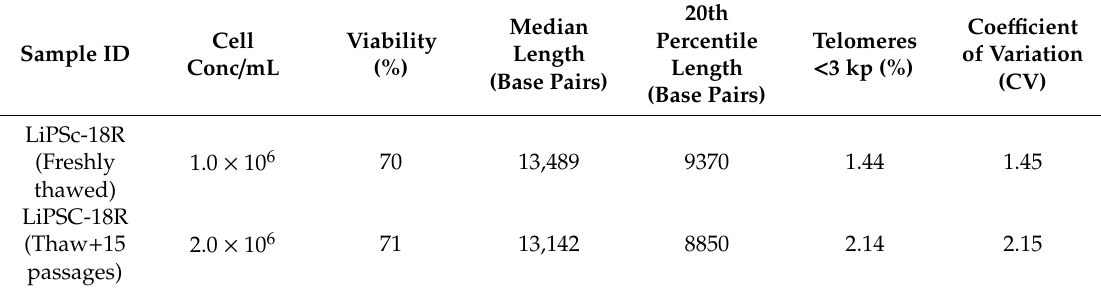
Table 2. Concentration, viability, and telomere length of the freshly-thawed and passaged iPSCs. The